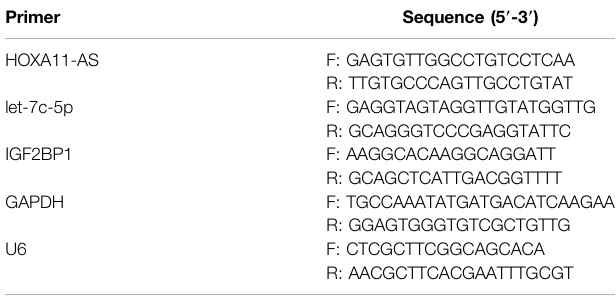
TABLE 1 | Primer sequences in qRT-PCR.